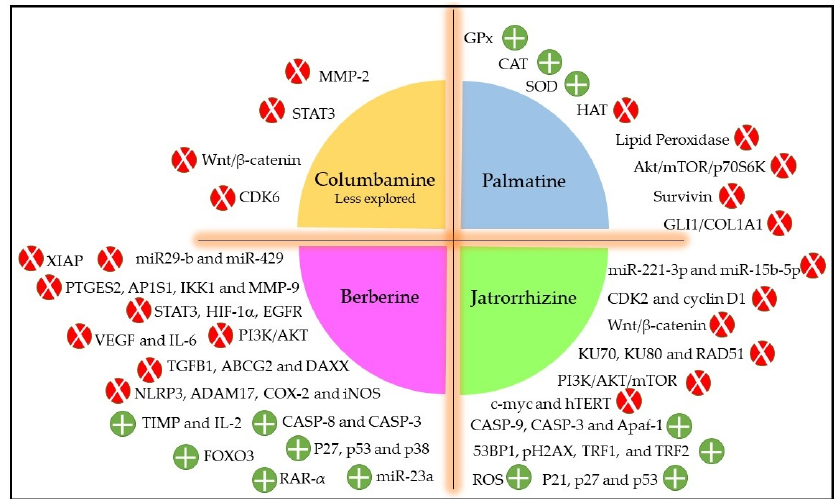
Figure 2. The probable antitumor mechanism of different protoberberines presents in A. chlorantha extracts. Red color indicates inhibition/reduction and green color indicates